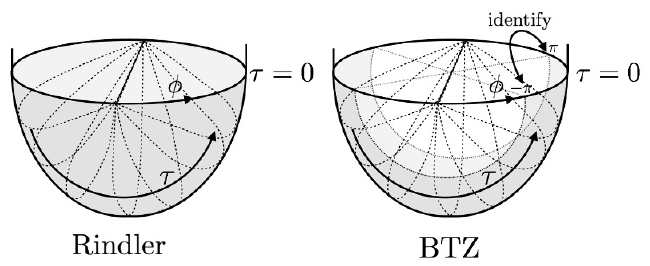
Figure 4 . Euclidean boundaries of the Rindler-AdS and the BTZ black hole. BTZ black holes are locally equivalent with the Rindler-AdS coordinate and they can be constructed by identifying the spatial coordinate (cid:30) in the Rindler coordinate as (cid:0) (cid:25)L < (cid:30) < (cid:25)L . where (cid:12) is a period of the Euclidean time which is (cid:12) = 2 (cid:25) in our coordinate system. Two CFTs are de(cid:12)ned on a cylinder: (cid:0) (cid:25)L < (cid:30) < (cid:25)L; (cid:0)1 < t < 1 while in the Rindler coordinate, CFTs are de(cid:12)ned on a plane: (cid:0)1 < (cid:30) < 1 ; (cid:0)1 < t < 1 . A thermo(cid:12)eld r double state is de(cid:12)ned by the Euclidean path-integral over the half torus while the Rindler spacetime is over the half sphere (see (cid:12)gure 4). A subregion (cid:0) (cid:25)L < (cid:30) < (cid:25)L in the